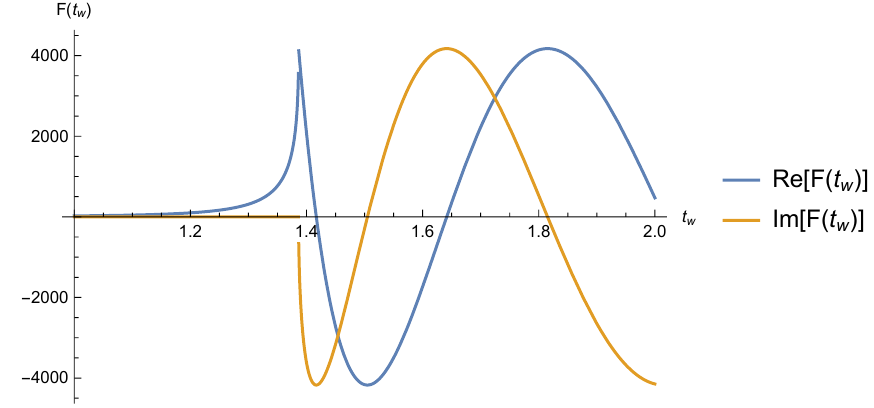
Figure 4 . The OTOC F ( t w ) calculated using the geodesic approximation which is valid for m 2 ‘ 2 (cid:29) 1. It develops oscillations after the scrambling time t > t (cid:3) = ‘ log( S dS ). To plot the (cid:12)gure we took G N = ‘ = 1 and m 2 ‘ 2 =